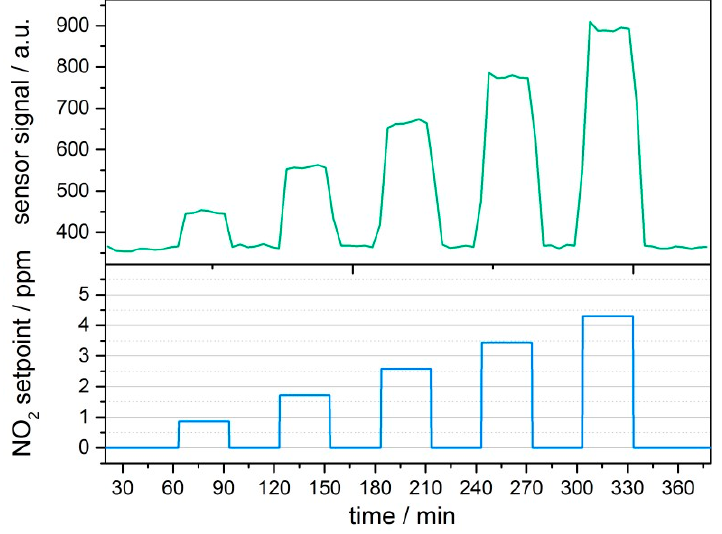
Figure 3. Gas measurement result of the photoacoustic sensor. Due to the sweeping over the complete resonance peak the data rate is around 0.25 min − 1 . The noise analysis showed a noise equivalent (1 σ ) of approximately 32 ppb. Therefore the sensor can detect concentrations around 200 ppb with 6 σ